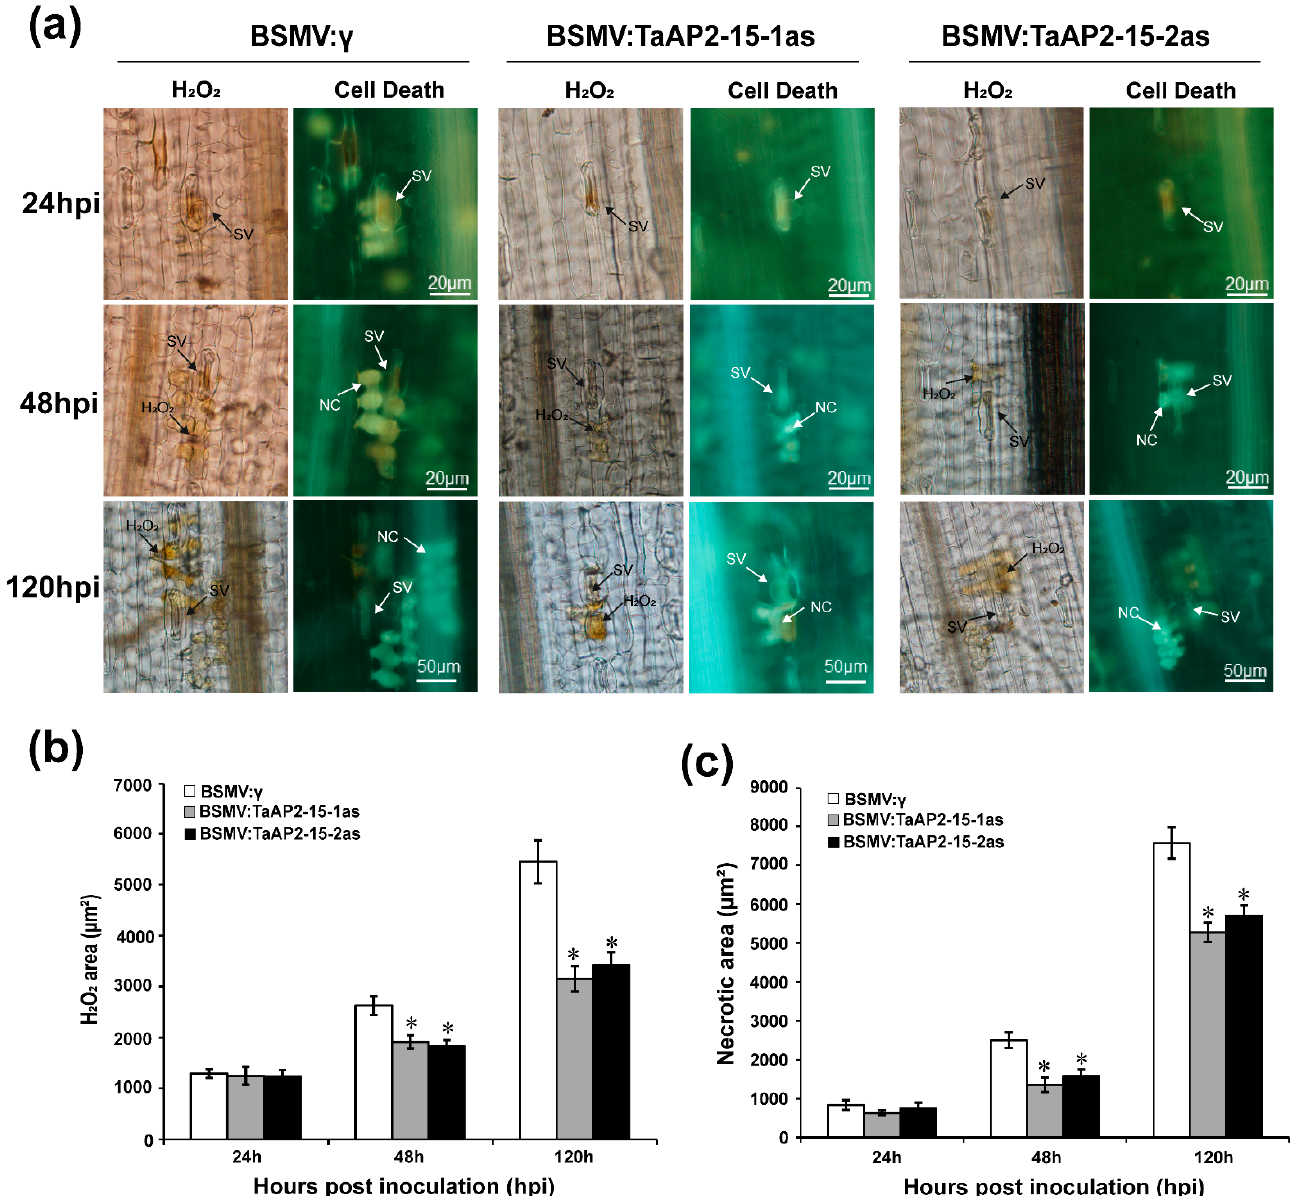
Figure 6. Knockdown of TaAP2-15 enhanced wheat susceptibility to avirulent Pst race CYR23 infection. ( a ) Histological observations of wheat leaves treated with BSMV and infected with CYR23. Wheat leaves pre-infected with BSMV: γ , TaAP2-15-1/2as were subsequently inoculated with Pst race CYR23, and H 2 O 2 and cell death were quantified. For H 2 O 2 burst and detection of necrosis, Pst CYR23 inoculated leaves were sampled at 24, 48 and 120 hpi. These samples were then stained with DAB (3,3-diaminobenzidine). Microscopic examination (Olympus BX-51) was performed to assess H 2 O 2 accumulation and necrosis around the infection sites. SV, substomatal vesicle; NC, necrotic cell. ( b ) H 2 O 2 accumulation was quantified via DP-BSW software (Olympus, Tokyo, Japan) by measuring the area where DAB is visible at the infection site. ( c ) The area of cell death was determined by calculating the fluorescence area. All data are the means of ±SE of samples obtained from three independent biological replications. Data were computed from three biological replications and 50 infection sites. Significant differences between TaAP2-15 -knockdown and control plants were estimated using Student’s t -test and are indicated by asterisks. *, p < 0.05.